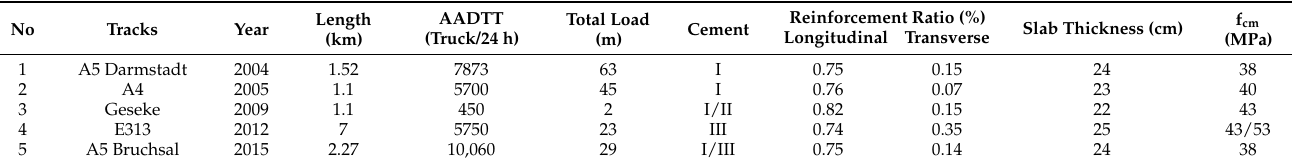
Table 1. Technical data of the CRCP test tracks.